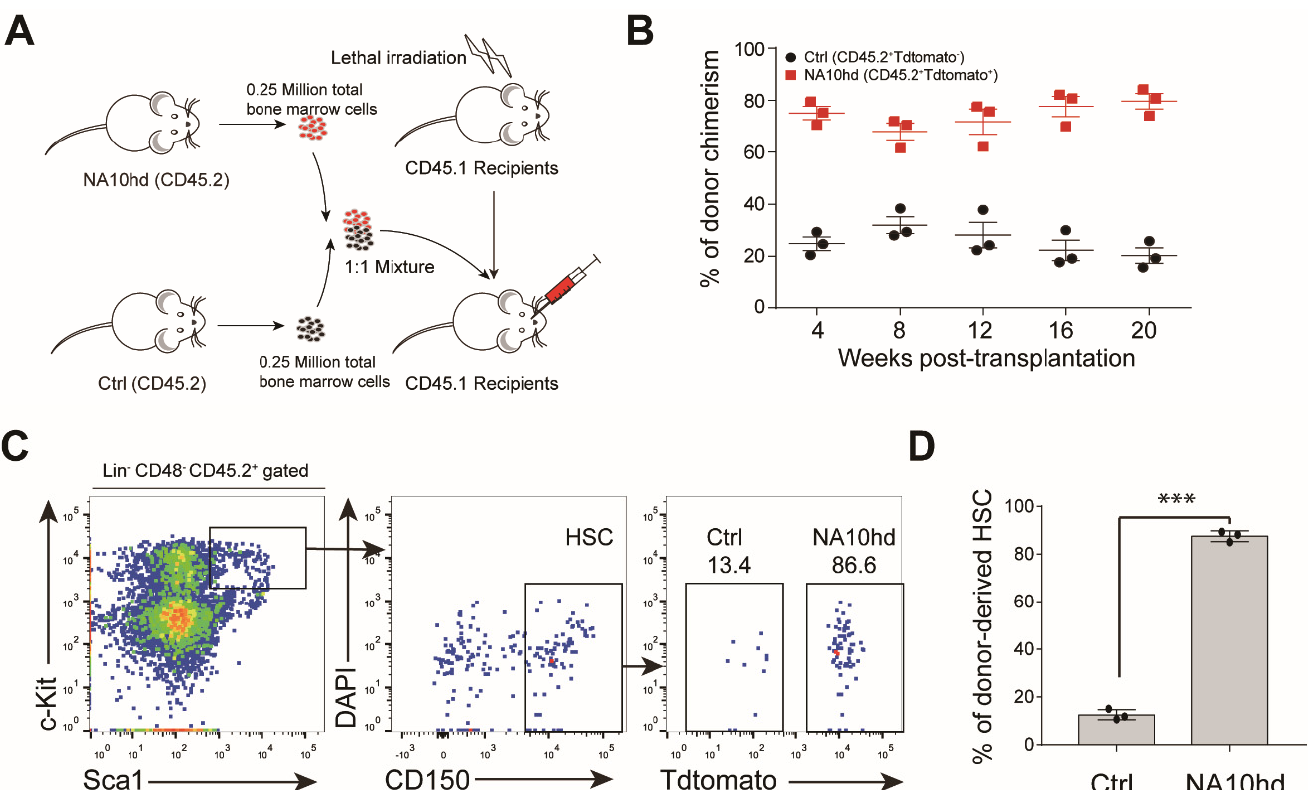
Figure 2. Hematopoietic stem cells expressing NA10hd protein demonstrates a competitive engraft advantage. ( A ) Diagram of the competitive transplantation assay of NA10hd and the littermate control (NA10hd LSL /+ , CD45.2) bone marrow hematopoietic stem cells. NA10hd and control bone marrow nucleated cells were transplanted into lethally irradiated (2 × 5.0 Gy) recipients (CD45.1) at a ratio of 1:1, and the percentage of donor cells and donor-derived specific lineage within donor-derived cells in peripheral blood were analyzed regularly after transplantation. ( B ) Donor chimerism in peripheral blood. ( C ) Flow cytometric analysis of donor-derived (NA10hd or control) hematopoietic stem cell (HSC) proportion in bone marrow of recipients 20 weeks post transplantation. Data are representative of two independent experiments. ( D ) Statistical analysis of NA10h d or control donor-derived HSC in recipient bone marrow 20 weeks post-transplantation. Data are represented as means ± SD. Unpaired Student’s t-test (two-tailed) was performed. Three mice, *** p < 0.001.